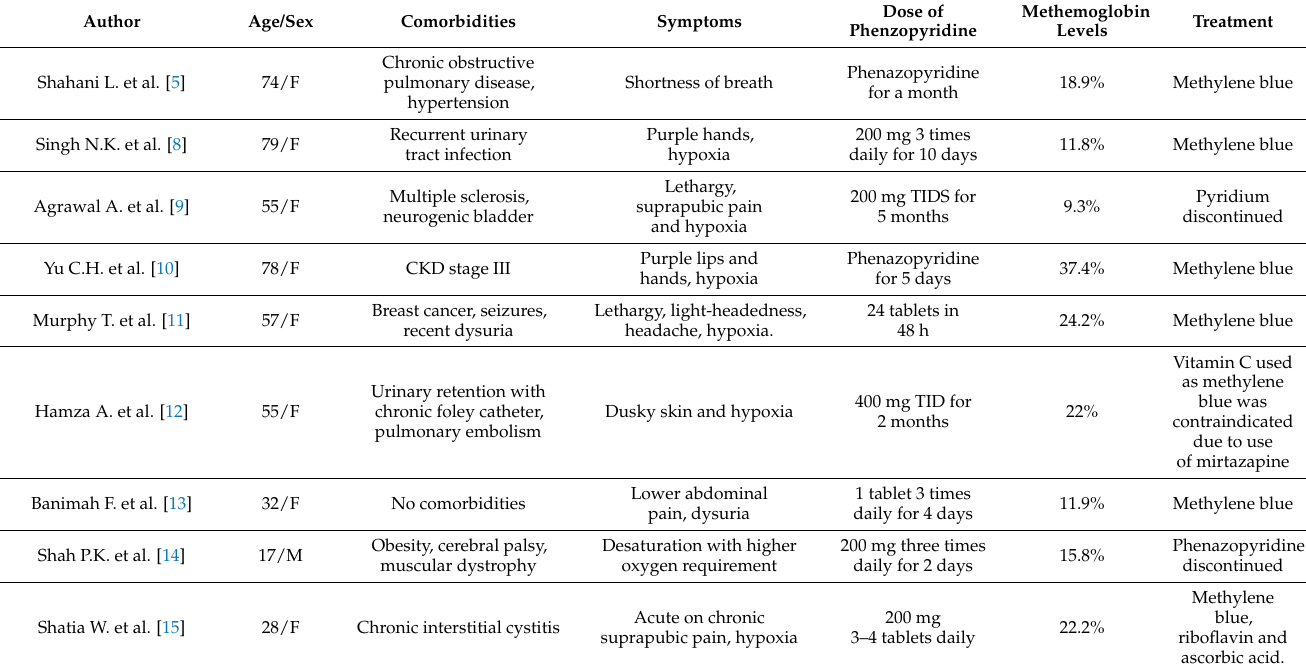
Table 3. The previous cases of phenazopyridine-induced methemoglobinemia reported in